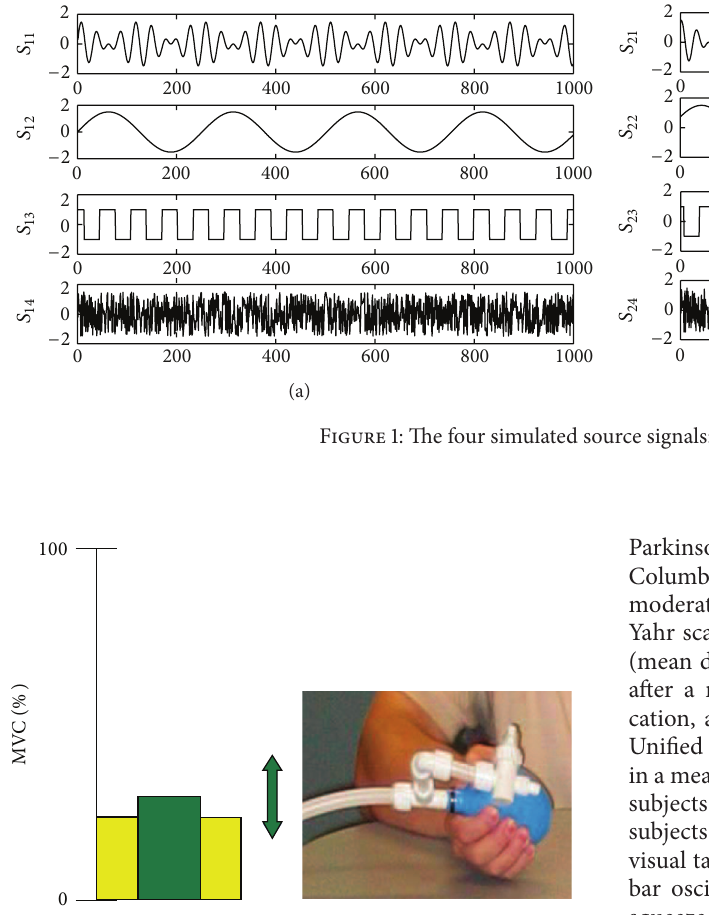
Figure 2: The squeezing task: the subject was instructed to follow the target bar (yellow) as closely as possible, and the green bar shows the force exerted by the